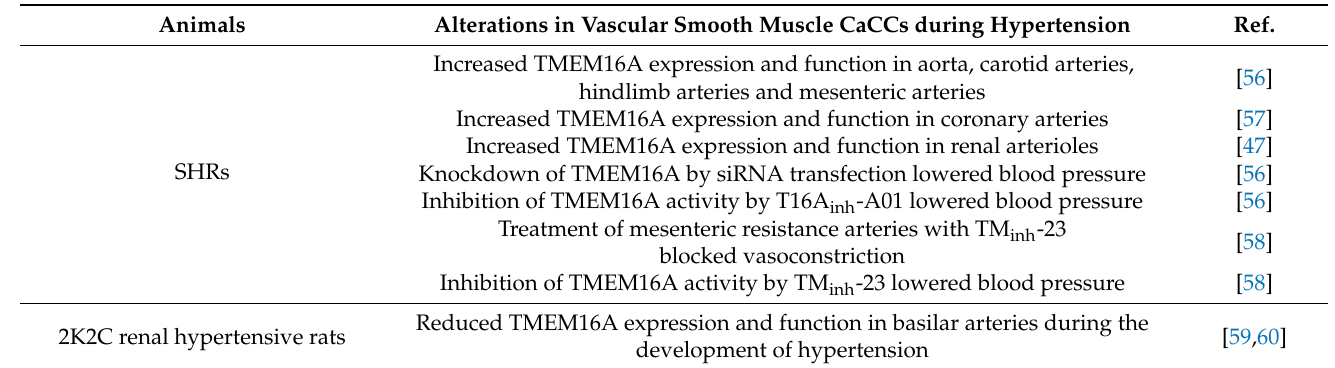
Table 1. Alterations in vascular smooth muscle Ca 2+ -activated Cl − channels during hypertension. Animals Alterations in Vascular Smooth Muscle CaCCs during Hypertension Ref. Increased TMEM16A expression and function in aorta, carotid arteries, hindlimb arteries and mesenteric arteries Increased TMEM16A expression and function in coronary arteries Increased TMEM16A expression and function in renal arterioles SHRs Knockdown of TMEM16A by siRNA transfection lowered blood pressure Inhibition of TMEM16A activity by T16A inh -A01 lowered blood pressure Treatment of mesenteric resistance arteries with TM inh -23 blocked vasoconstriction Inhibition of TMEM16A activity by TM inh -23 lowered blood pressure Reduced TMEM16A expression and function in basilar arteries during the 2K2C renal hypertensive rats development of